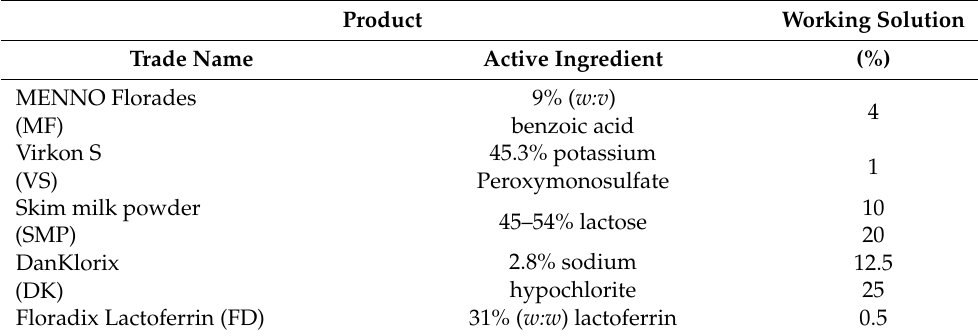
Table 2. List of products, their active ingredients, and the tested concentration of the working solution for inactivating Tomato brown rugose fruit virus (ToBRFV). Product Working